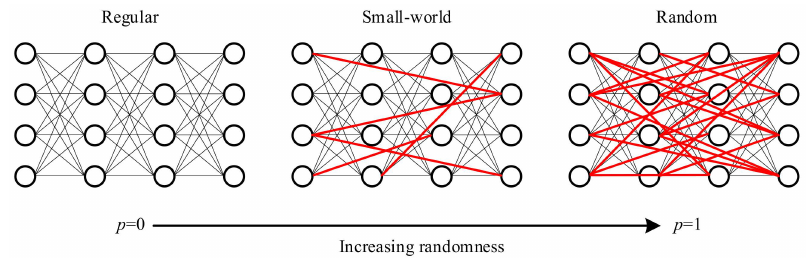
Figure 4. The random add-edge procedure from a regular back propagation (BP) neural network to a random one.